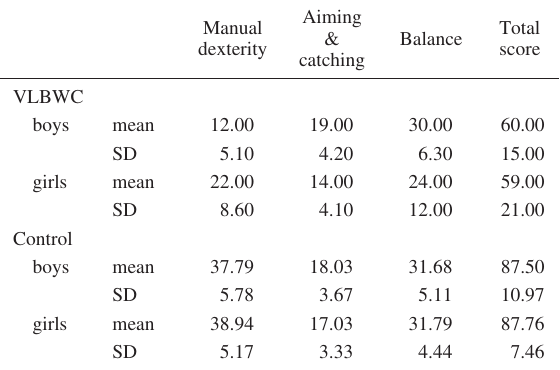
Table 3. The raw score for 6-year-old very low birth weight children (VLBWC) and controls in both girls and